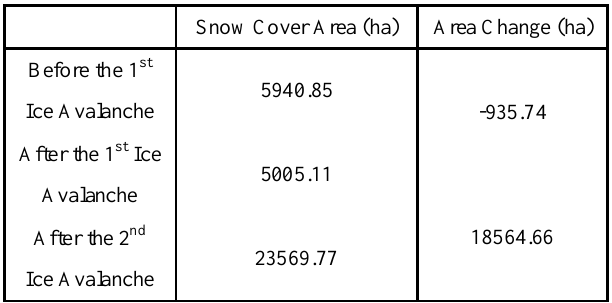
Table 3. Snow cover area statistics for the mountain where the ice avalanches were located